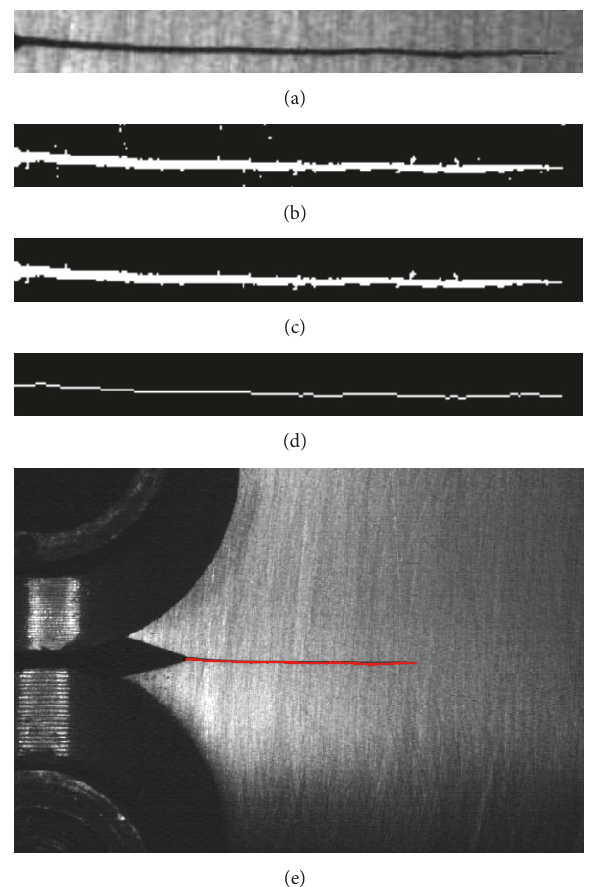
Figure 6: Result images in the process of crack extraction. (a) Original crack; (b) crack binary image with noise; (c) clean crack binary image; (d) single pixel skeleton image; (e) actual detected crack in the CT specimen.